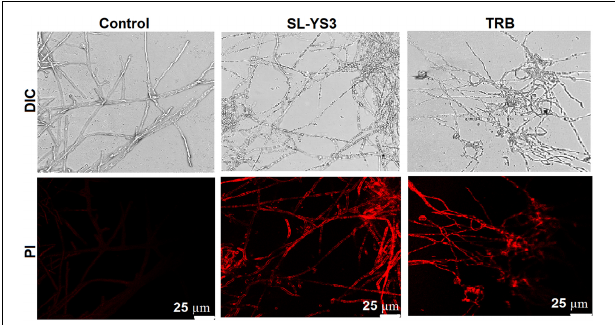
FIGURE 8 | Confocal laser scanning microscopic (CLSM) images of the effect of sophorolipid produced by R. babjevae YS3 and terbinafine (TRB) on mature biofilms of T. mentagrophytes . Scale bar = 25 µ